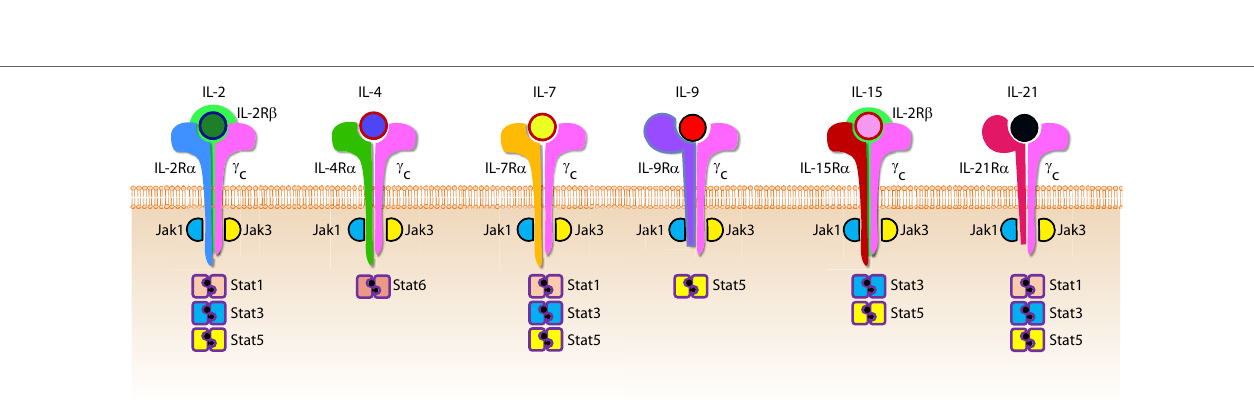
FiGURe 6 | Role of common gamma-containing receptors in natural killer (NK) cell development. The common gamma chain-containing receptor family consists of six members, interleukin (IL)-2R, IL-4R, IL-7R, IL-9R, IL-15R, and IL-21R. Each one of them is distinguished from others by their unique α -chains. IL-2R β is shared by IL-2R and IL-15R complexes. In mouse, NK cell progenitors (NKPs) utilize IL-7R early during their transition from Pre-NKPs into refined-NKPs. In human, apart from its role in the early development, IL-7 also regulates the survival and expansion of mature CD56 bright NK cells. IL-15R and IL-21R are required by NK cells